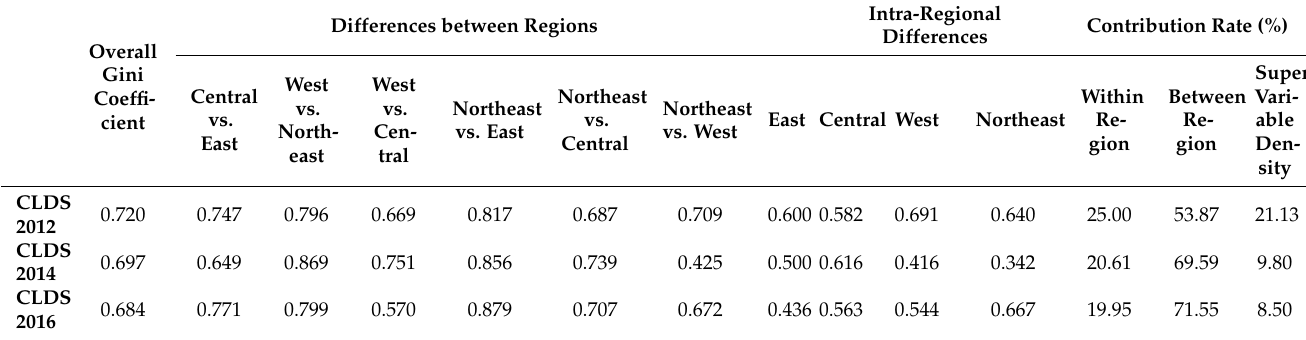
Table 3. Comparison and decomposition of the Gini coefficient for the rural housing rental rate across